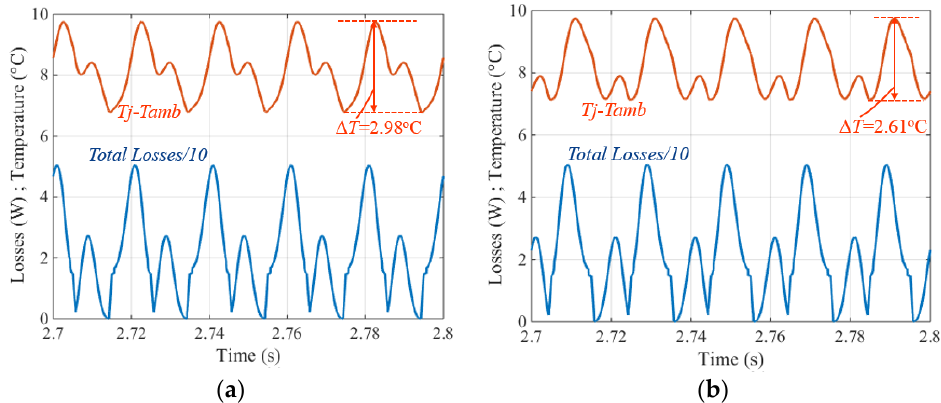
Figure 16. Instantaneous losses (bottom curves) and junction temperature variation (upper curves) for different angles between the current and the voltage ( φ ): ( a ) φ = −π ; ( b ) φ = + π . Although average losses are the same and loss waveforms are the same (but mirrored), the junction temperatures have different waveforms and amplitudes for these two angles.